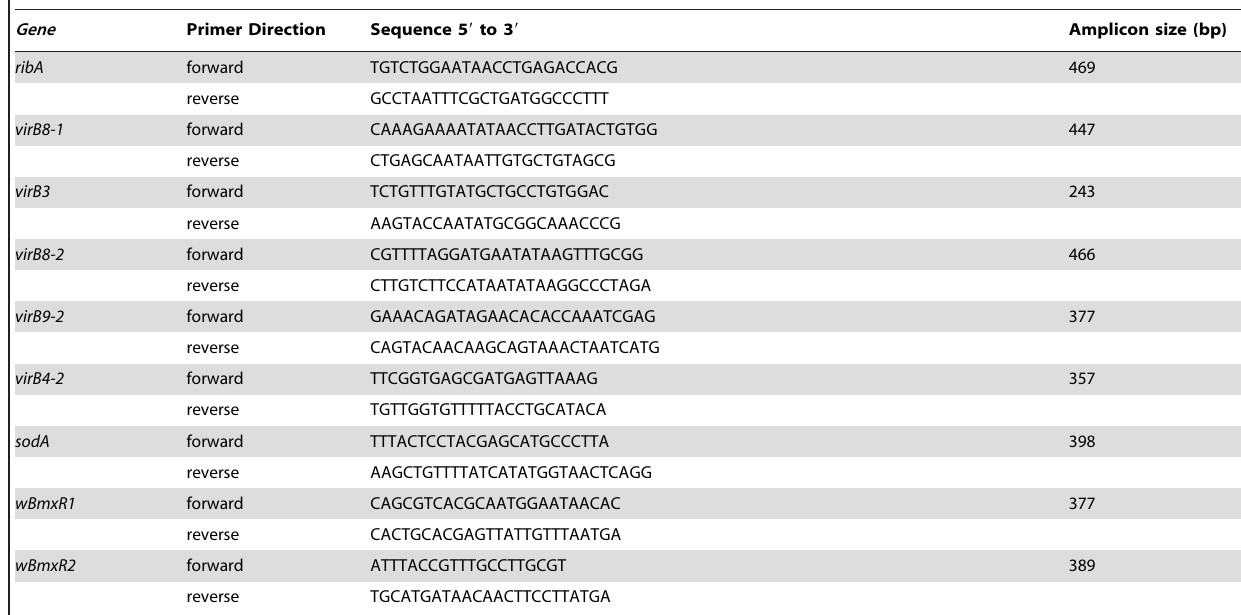
Table 3. Primers used to amplify promoter regions of various genes.